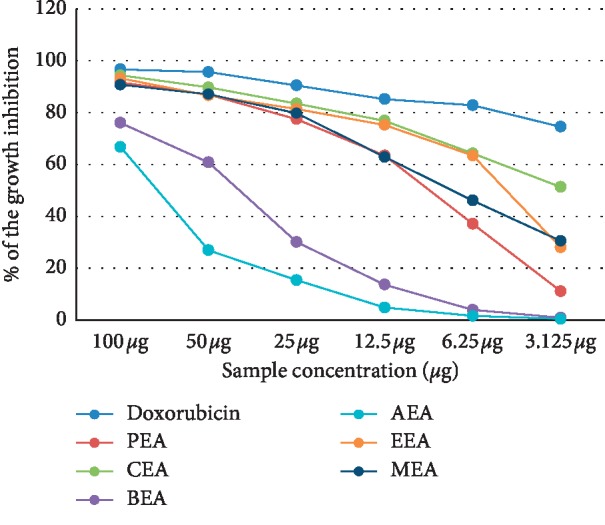
Percentage inhibition of cell growth of D. dichotoma extracts against the HepG-2 cell line. PEA (petroleum ether), CEA (chloroform), EEA (ethyl acetate), BEA ((n)-butanol), AEA (remaining aqueous mother liquor) fractions, and MEA (methanol).